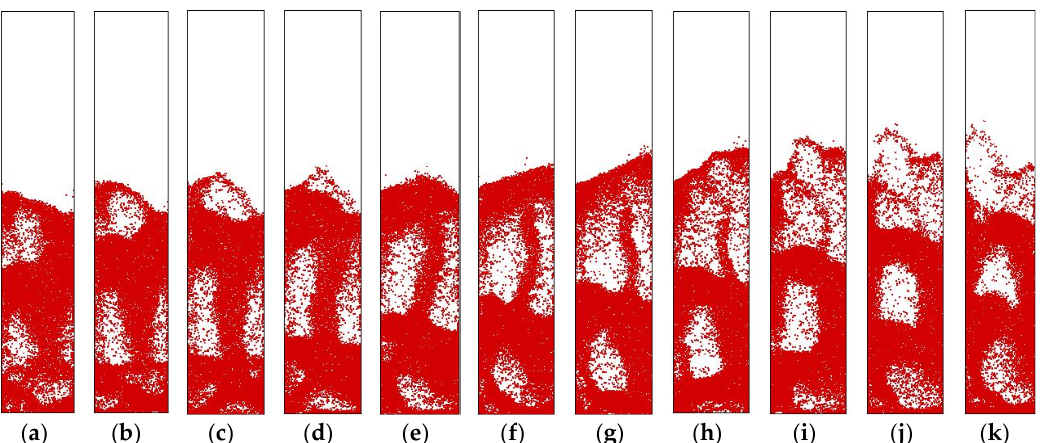
Figure 13. Snapshots of particle distribution obtained by the PCPM for a two dimensional fluidized bed at the later stage: the phenomenon of bubble merging along the transverse direction. ( a ) 7.72 s. ( b ) 7.80 s. ( c ) 7.88 s. ( d ) 7.96 s. ( e ) 8.02 s. ( f ) 8.10 s. ( g ) 8.18 s. ( h ) 8.26 s. ( i ) 8.32 s. ( j ) 8.40 s. ( k ) 8.48 s.